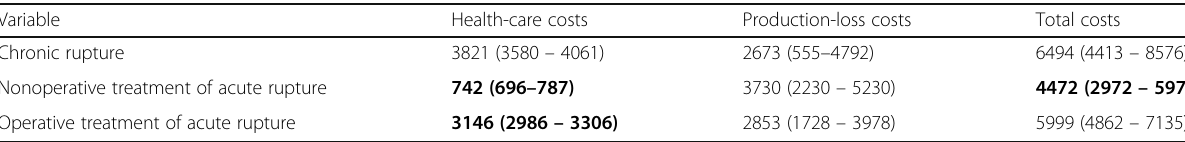
Table 3 Comparison of the mean (CI 95%; lower – upper) economic cost (EUR) per patient between chronic Achilles tendon ruptures and the operative and nonoperative treatment of acute Achilles tendon ruptures. Significant difference compared to chronic Achilles tendon ruptures is presented by bold font Variable